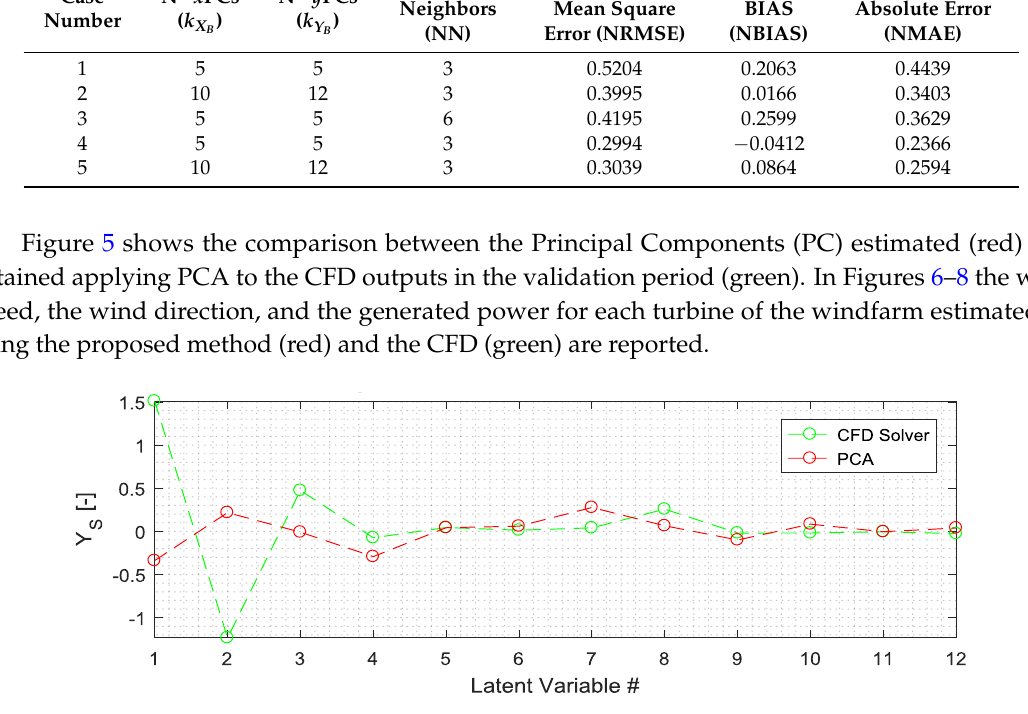
Figure 5. Comparison between latent variables extracted from CFD solver output (green) and obtained by using of the PCA-based CBR for the 2nd forecasting hour.